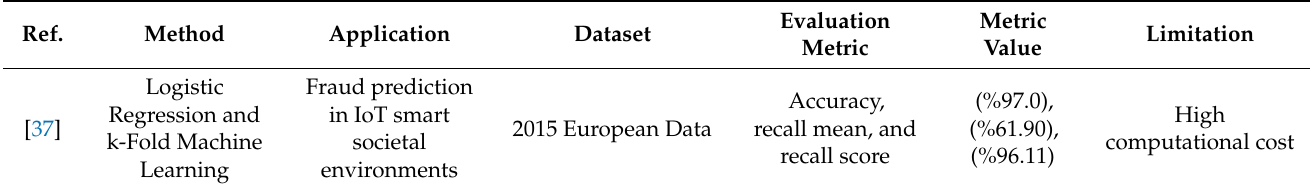
Table 3. Comparative analysis of fraud detection